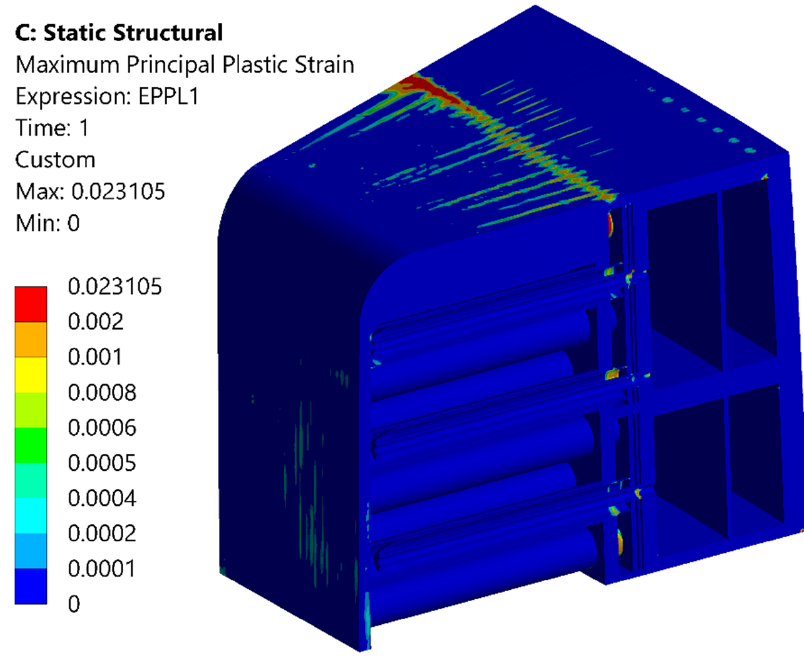
Figure 10. Maximum principal strain contour on BB cap region—inelastic analysis. Table 2. Assessment against IPFL and ILFED damage modes according to inelastic criteria. Part